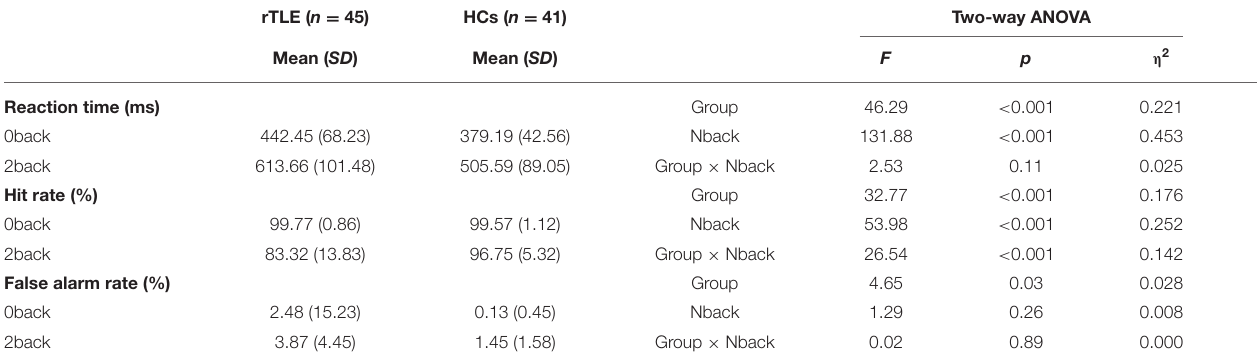
TABLE 2 | VSWM_Nback performance between rTLE and HCs.